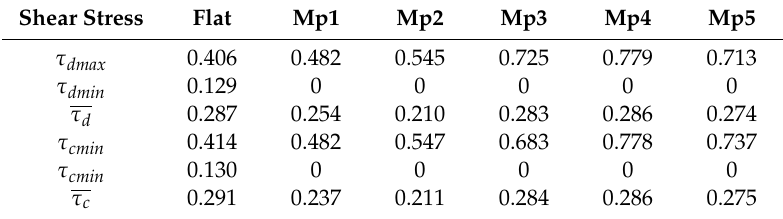
Table 3. Shear stresses under microbes for smooth and microstructural surfaces in three periods. Shear Stress Table 4. Shear stresses gradient under microbes for microstructural surfaces in three periods. Shear Stress Gradient Mp1